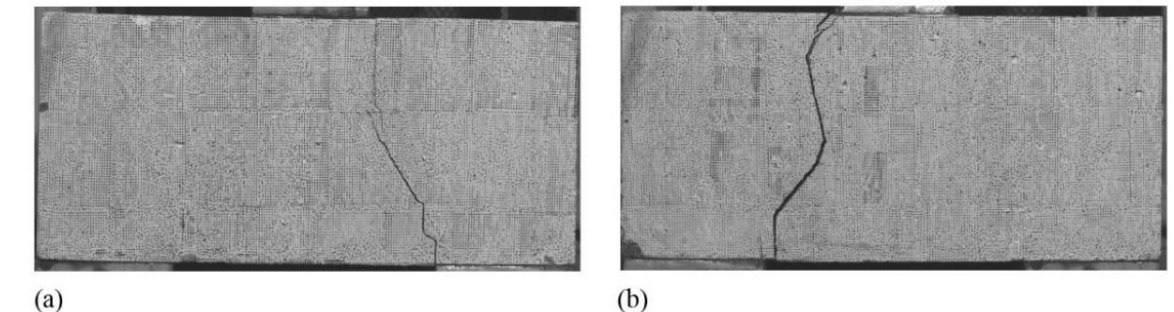
Figure 9. Failure modes of specimens: ( a ) Type III specimen; ( b ) Type IV specimen.